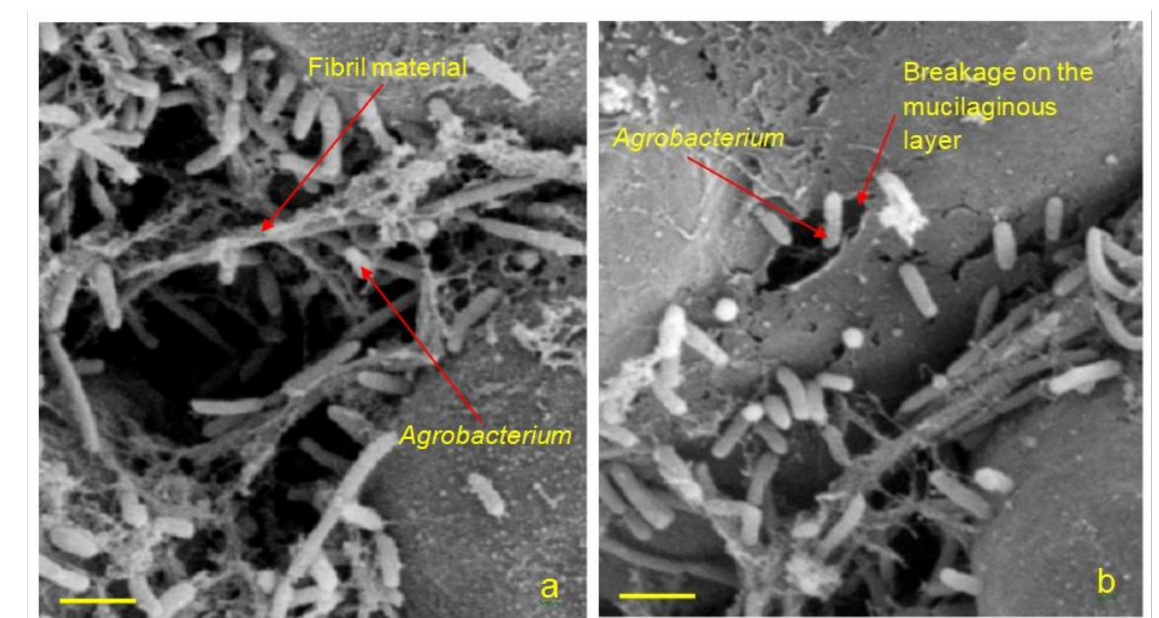
Figure 2. Scanning electron microscope (SEM) imaging on the attachment of Agrobacterium on rice callus surface. ( a ) Agrobac- terium attached to the cell membranous layer, anchoring the rice callus with fibril material (magnification = 8000 × , bar = 2 µ m). ( b ) Agrobacterium entering into the hole formed on the mucilaginous layer at the outer surface of the callus, facilitating the T-DNA transfer process (magnification = 8000 × , bar = 2 µ